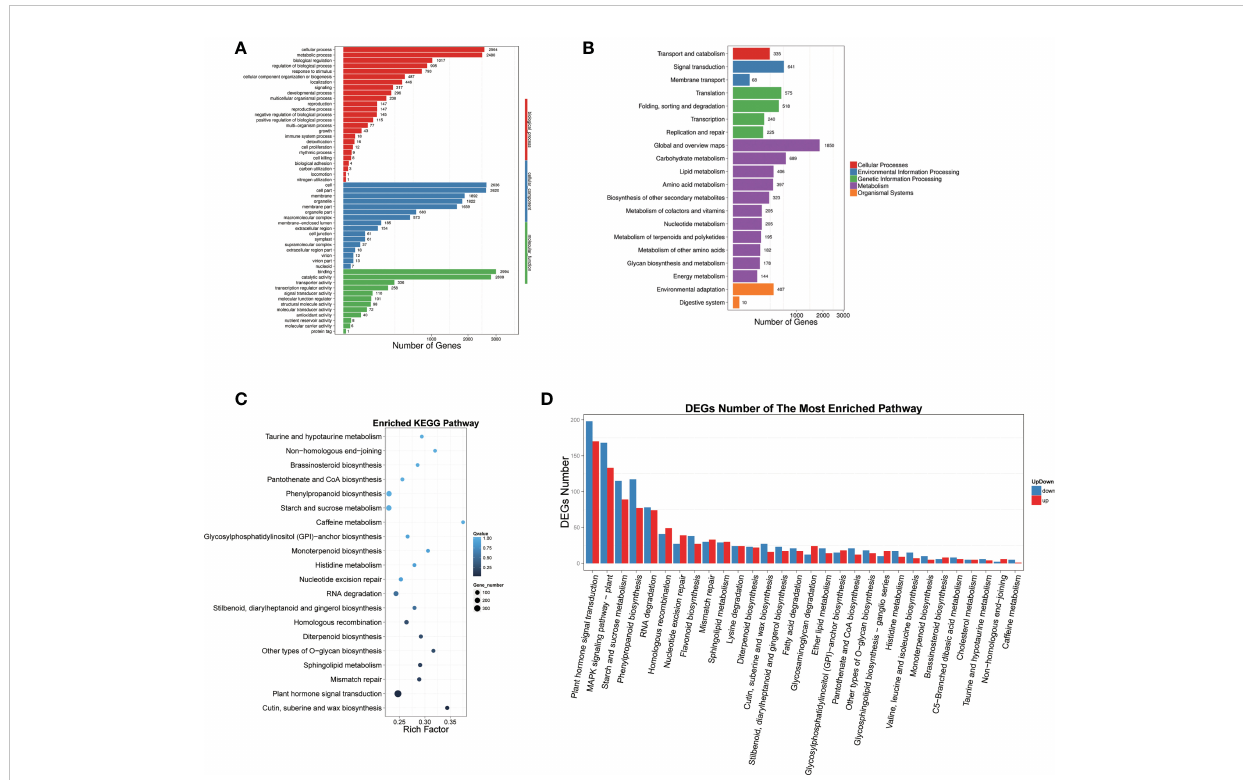
FIGURE 3 GO and pathway enrichment analyses were performed for all signi fi cant DEGs. (A) GO classi fi cation map of DEGs, the X-axis represents the number of genes, and the Y-axis represents the GO functional classi fi cation. (B) The X-axis represents the proportion of genes accounted for and the Y-axis represents the KEGG functional classi fi cation. (C) Pathway enrichment of DEGs, X-axis represents enrichment factor value, Y-axis represents pathway name. The color represents q-value (the whiter the color the larger the value, the bluer the smaller the value), the smaller the value means The smaller the value, the more signi fi cant the enrichment result. The size of the dot represents the number of DEGs. (D) Enrichment pathways of up- and down-regulated DEGs. The X-axis represents the Pathway entry, and the Y-axis represents the number of up- and down-regulated genes corresponding to the Pathway